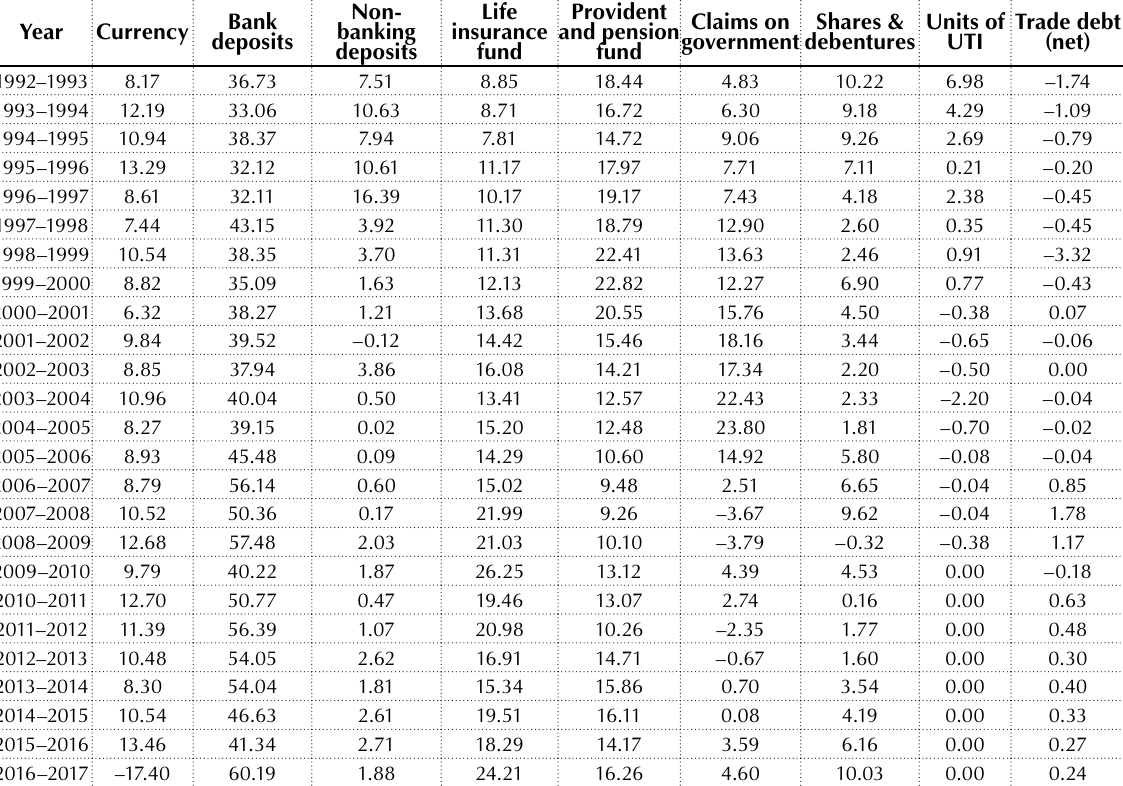
Table 2. Risks and return of market indices